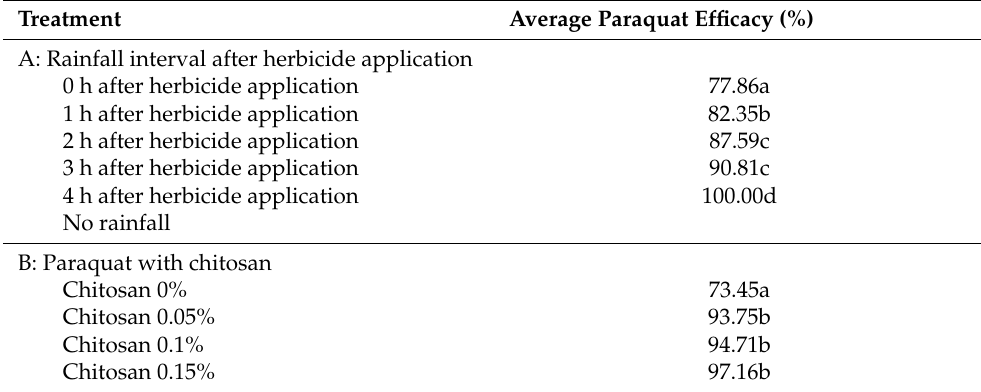
Table 1. Effect of simulated rainfall on herbicidal efficacy of a mixture of paraquat and chitosan against Ageratum conyzoides at different time intervals after mixture application.